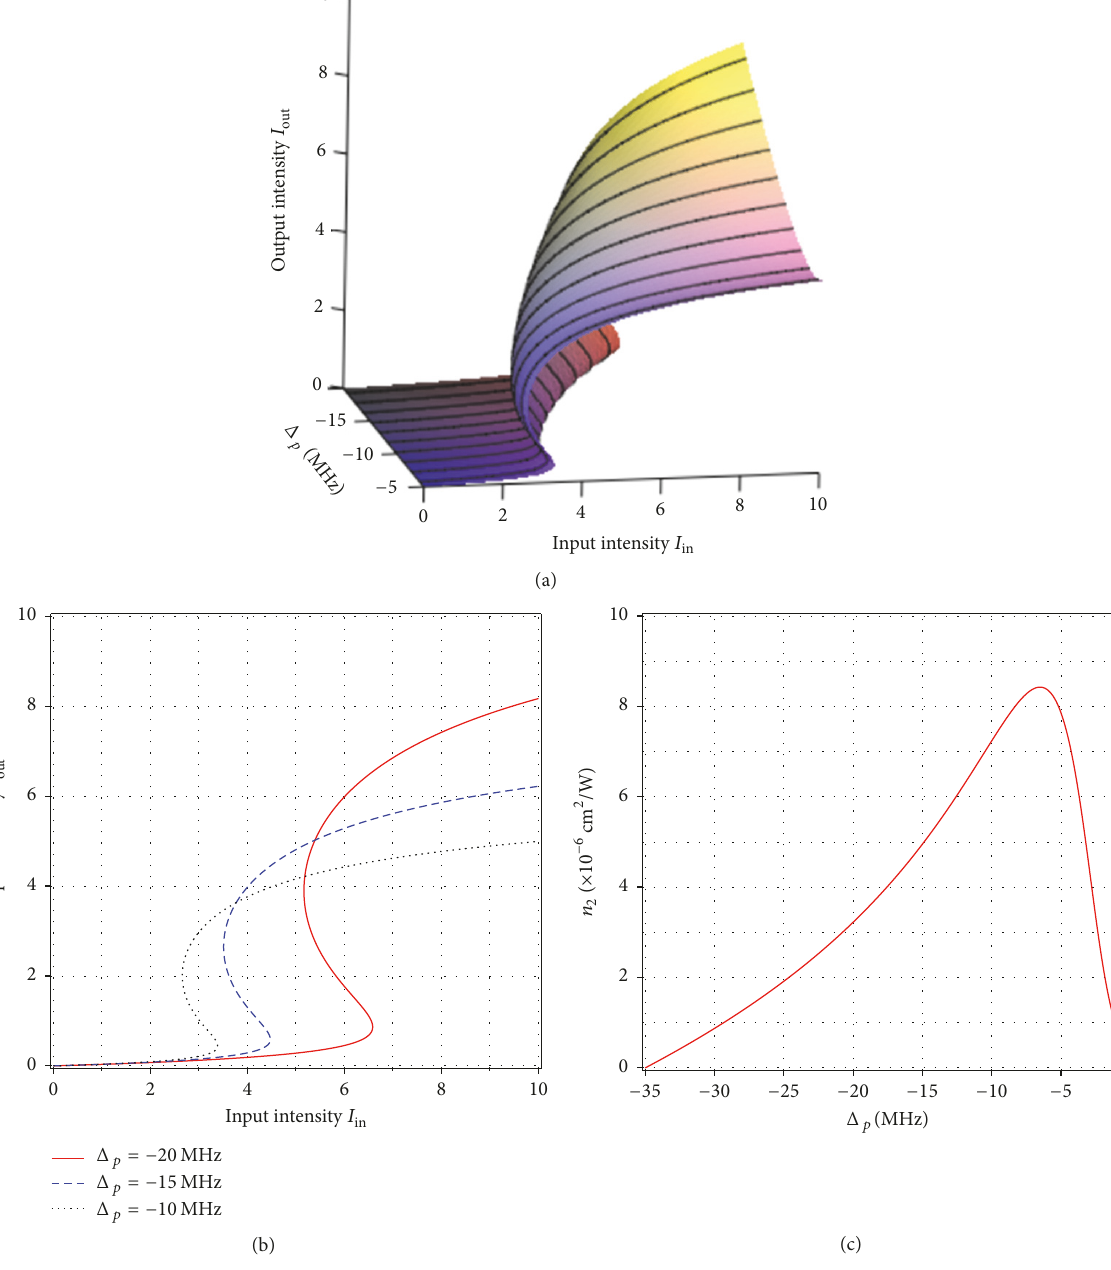
Figure 2: (a) Surface plot of the OB; (b) OB curves at particular values of the probe frequency detuning; (c) variation of the Kerr nonlinear coefficient 𝑛 2 versus the probe detuning. All the plots given at the fixed values Δ 𝑐 = 0 , Ω 𝑐 = 70 MHz, and 𝑇 = 300